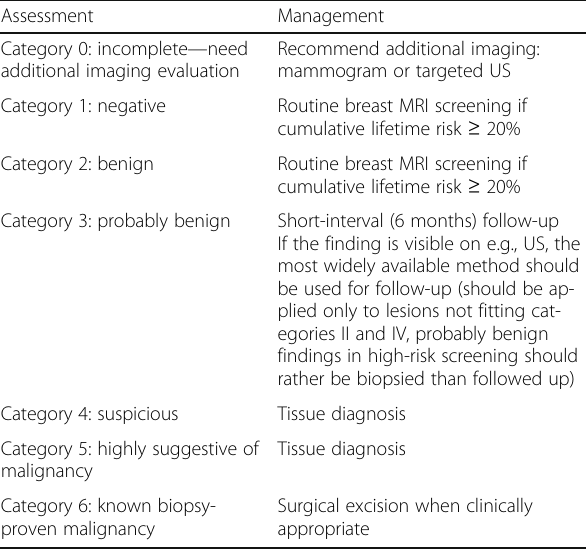
Table 3 BI-RADS MRI assessment categories and